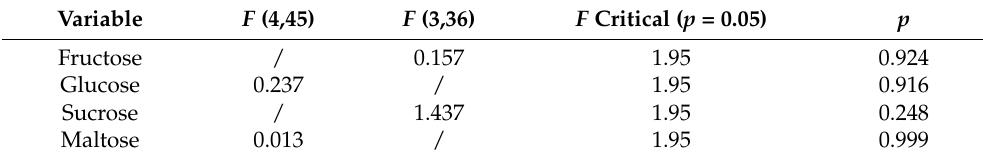
Table 7. Analysis of variance (ANOVA) of sugar content (Percent) in HPLC and qNMR methods a